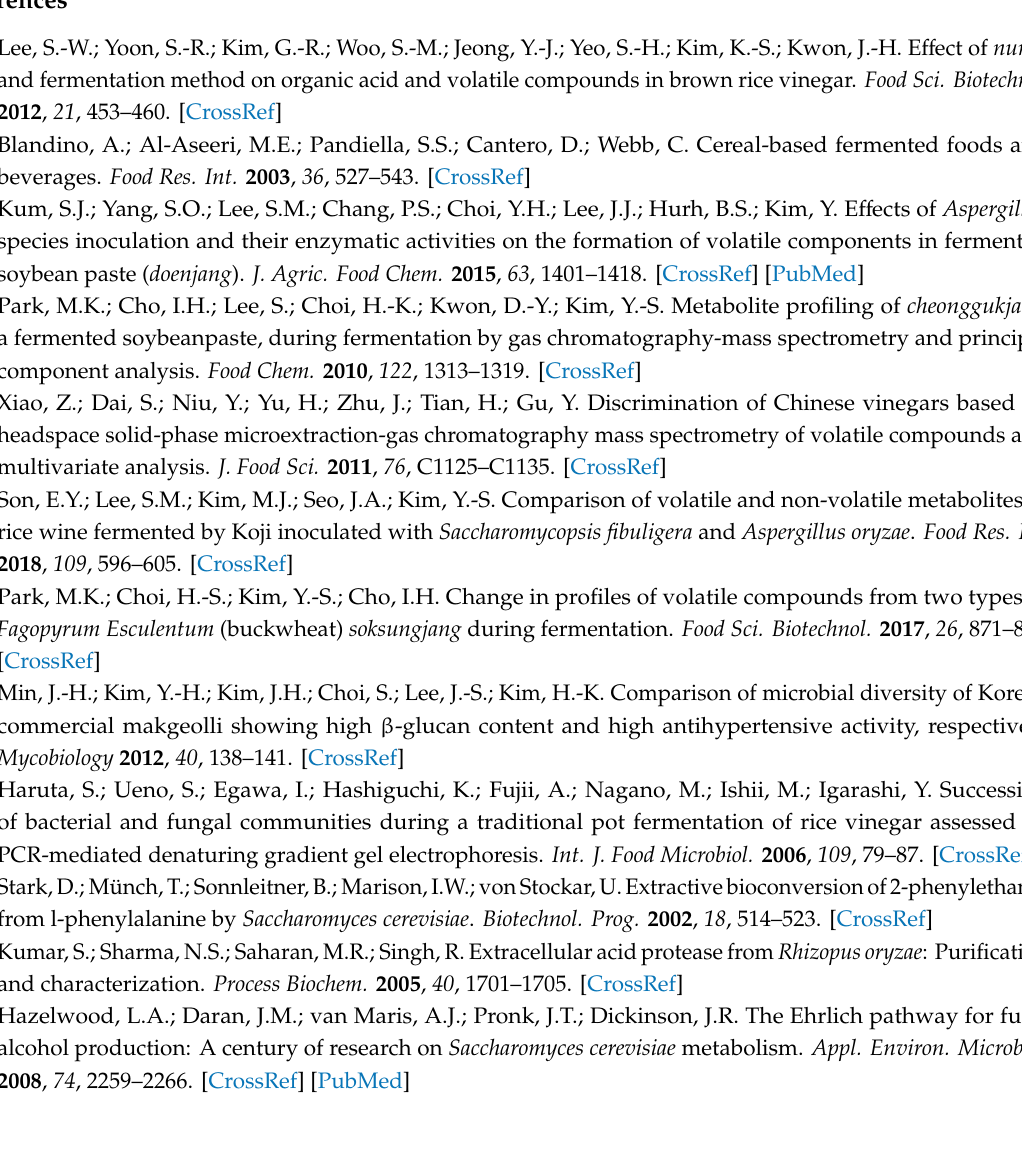
Table S1: The fold changes of volatile compounds in fermented rice samples (purple boxes indicate newly detected volatile